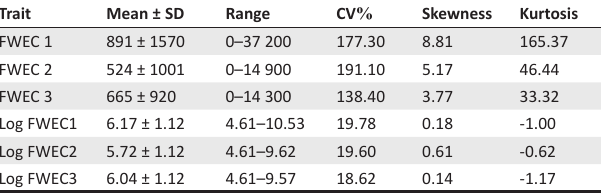
TABLE 1: Descriptive statistics for faecal worm egg counts of Merino sheep before and after transformation.